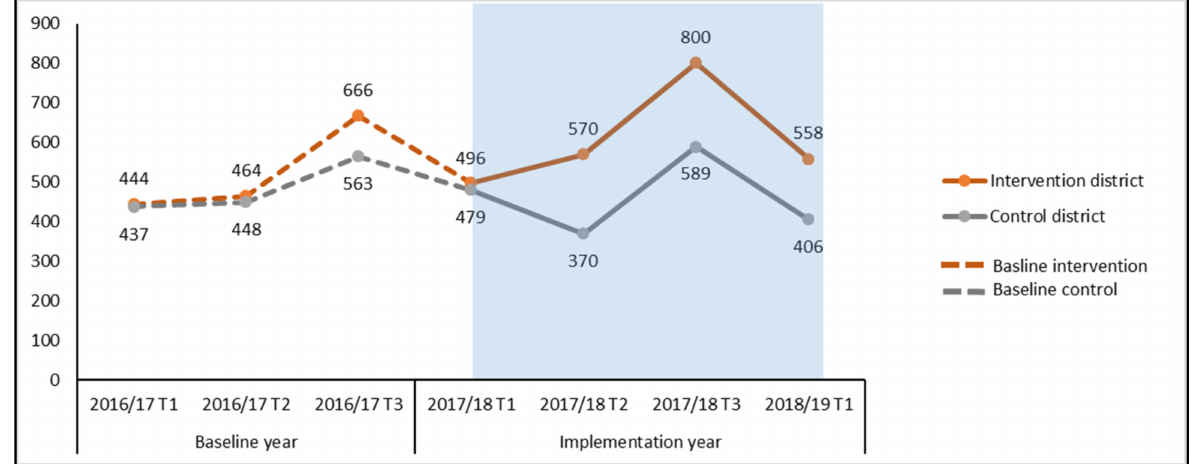
Figure 2. Comparison of case notification before and after implementation of active case finding (ACF) interventions (unadjusted data).